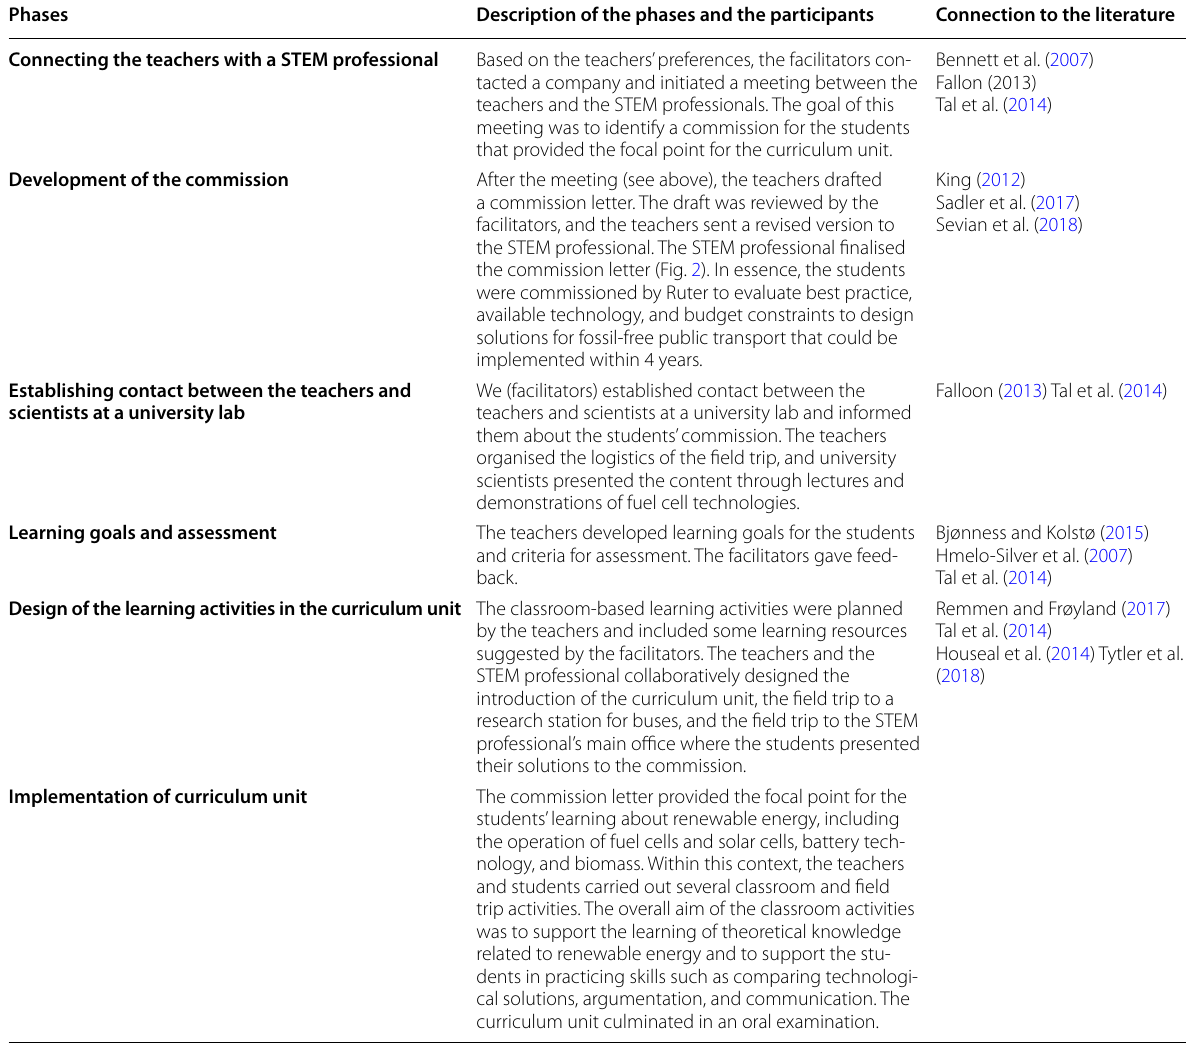
Table 1 Description of the development phases and implementation of the curriculum